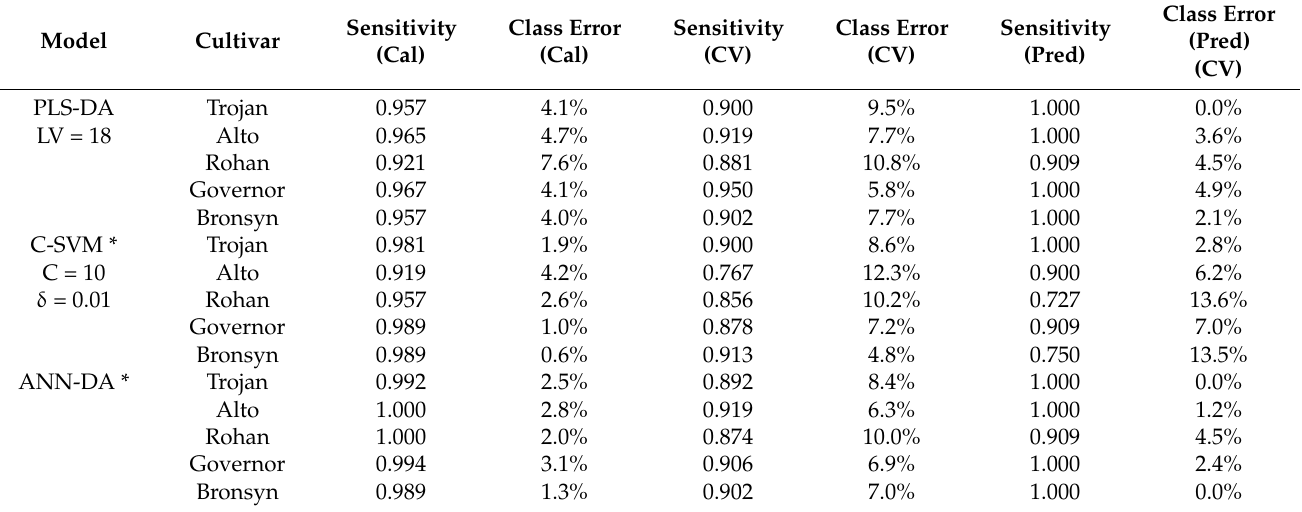
Table 5. Classification models using full spectra for cultivars Trojan ( n = 369); Alto ( n = 86); Rohan ( n = 277); Governor ( n = 181) and Bronsyn ( n = 92) calibration dataset and Trojan ( n = 16); Alto ( n = 10); Rohan ( n = 11); Governor ( n = 11); Bronsyn ( n = 4) prediction